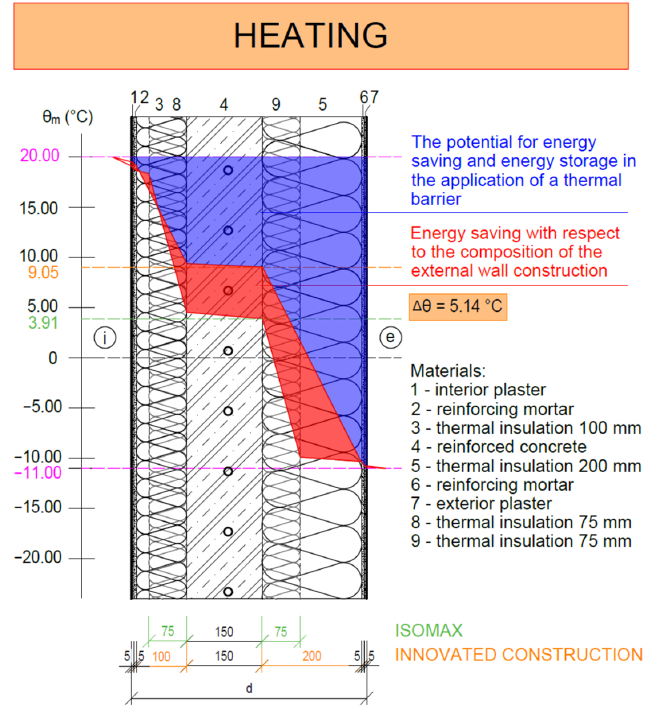
Figure 25. The course of isotherms characterizing the heat transfer through the ISOMAX panel construction and the upgraded panel construction in the heating season. q i — heat flow towards the interior (W/m 2 ), q e — heat flow towards the exterior (W/m 2 ), θ i = 20 °C—internal calculation temperature (°C), θ e = − 11 °C—outdoor calculation temperature (°C), θ pi — interior surface temperature (°C), θ pe — exterior surface temperature (°C), ∆ θ — temperature difference, i— interior, e— exterior.